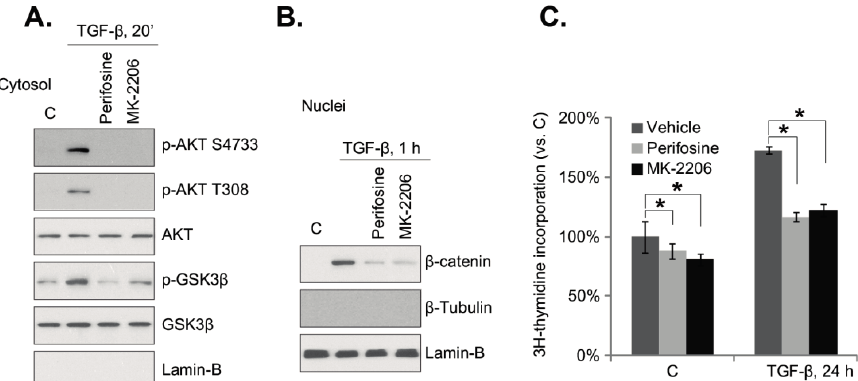
Figure 4. β -catenin silencing inhibits TGF- β 1-induced mouse PSC proliferation. The lentiviral particles containing different β -catenin-shRNAs (targeting non-overlapping sequence, -1/-2) or scramble-shRNA (15 μ L/mL each) were added to mouse PSCs (Day 4) for 48 h. Afterwards, mouse PSCs were treated with TGF- β 1 (25 ng/mL) for one hour; cytosol and nuclear fractions were isolated, and the expression of indicated proteins in the corresponding fraction was tested by western blotting ( A , B ); The above PSCs were also treated with TGF- β 1 (25 ng/mL) for 24 h, and cell proliferation was tested by